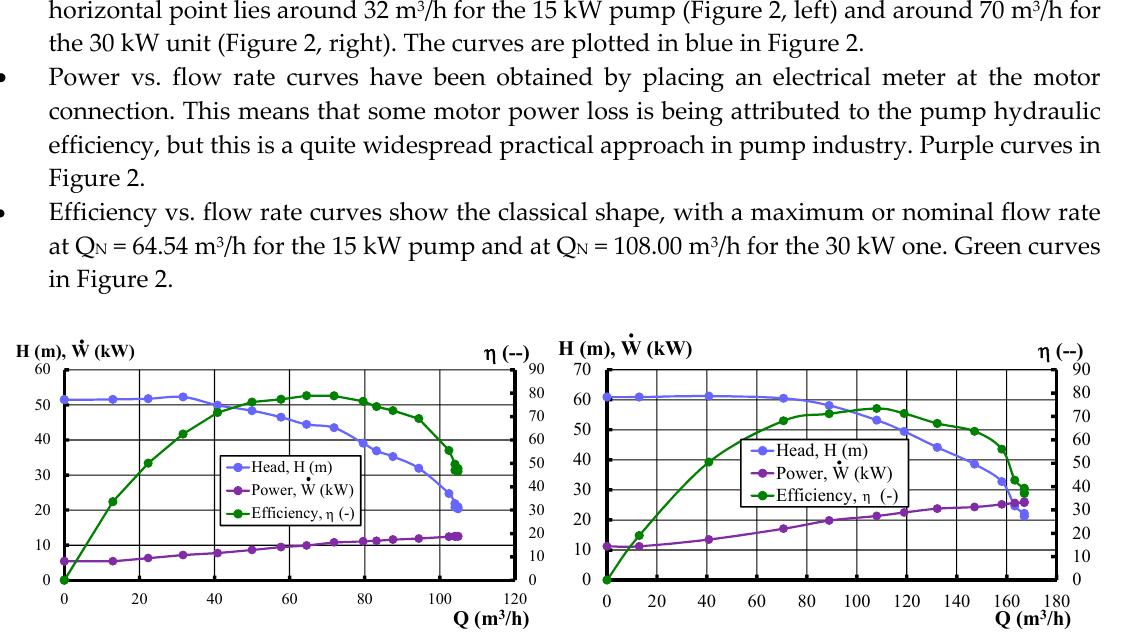
Figure 2. Performance curves for the two studied pumps: 15 kW at the left and 30 kW at the right